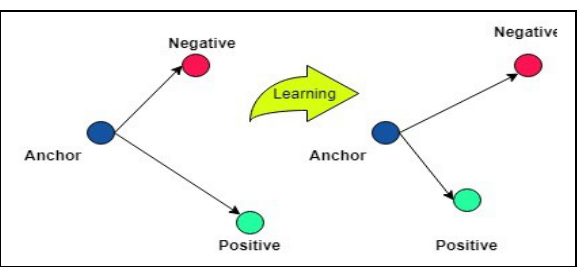
Fig. 5(b) Test case1 without Glasses Fig. 5(b) : Test case1 without